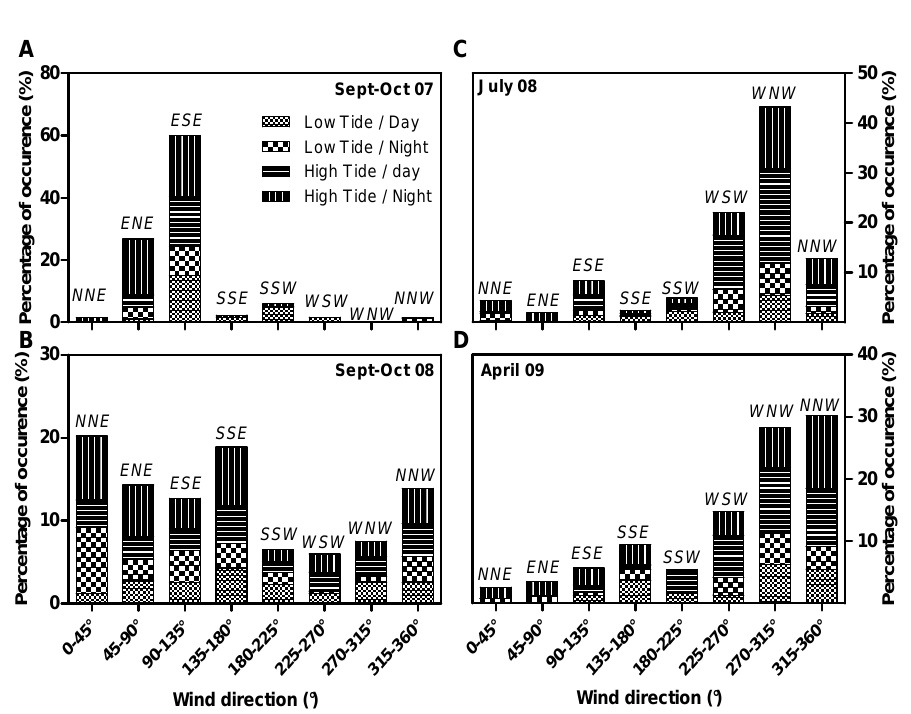
Fig. 7. The wind directions during the four EC measurements in the Arcachon flat by percentage of occurrence and functions to the tidal and diurnal rhythms (low tide/day, low tide/night, high tide/day and high tide/night). (A) 30 September to 3 October 2007 (St. 2), (b)